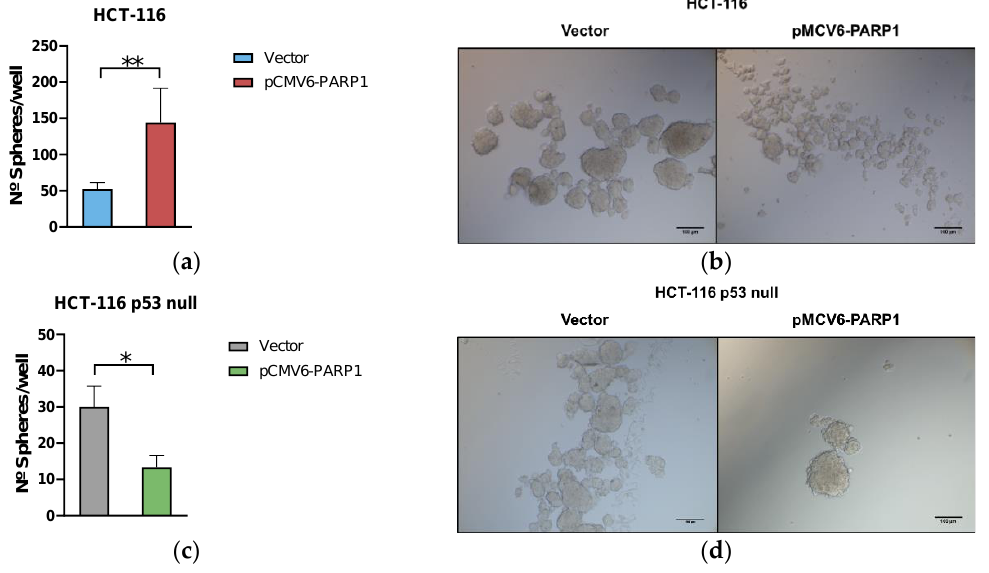
Figure 4. Cells were pCMV6-PARP1 or mock transfected (Vector), collected at 72 and 96 h after transfection and used to characterize the percentage of ALDH1+ cells by flow cytometry in total population (TP) of ( a ) HCT-116, ( b ) HCT-116 p53 null. In other experiments, cells were also collected at 72 and 96 h after pCMV6-PARP1 or empty vector transfections and used to quantify in TP ( c ) the percentage of CD144+/CD326+/CD133+ and ( d ) the percentage of CD44+/CD326+ cells in HCT-116, and ( e ) the percentage of CD44+/CD326+ cells in HCT-116 p53 null cells. Data represent the mean ± SD of two experiments performed in duplicate. * p < 0.05; ** p < 0.01; *** p < 0.001 vs. vector.